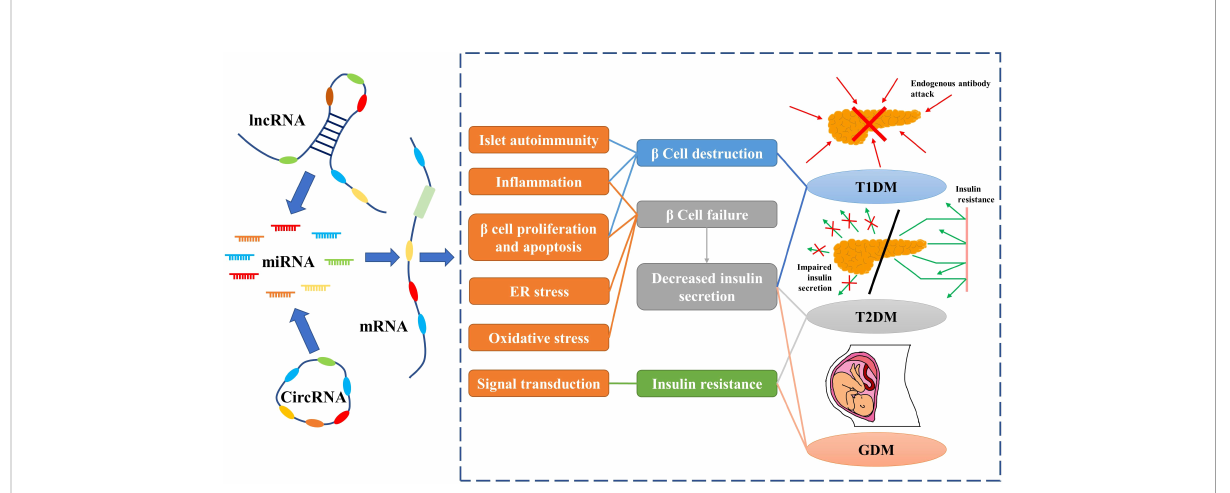
FIGURE 2 Non-coding RNAs play an important role in diabetes by regulating mRNAs. Red arrows indicate endogenous antibodies and green arrows indicate